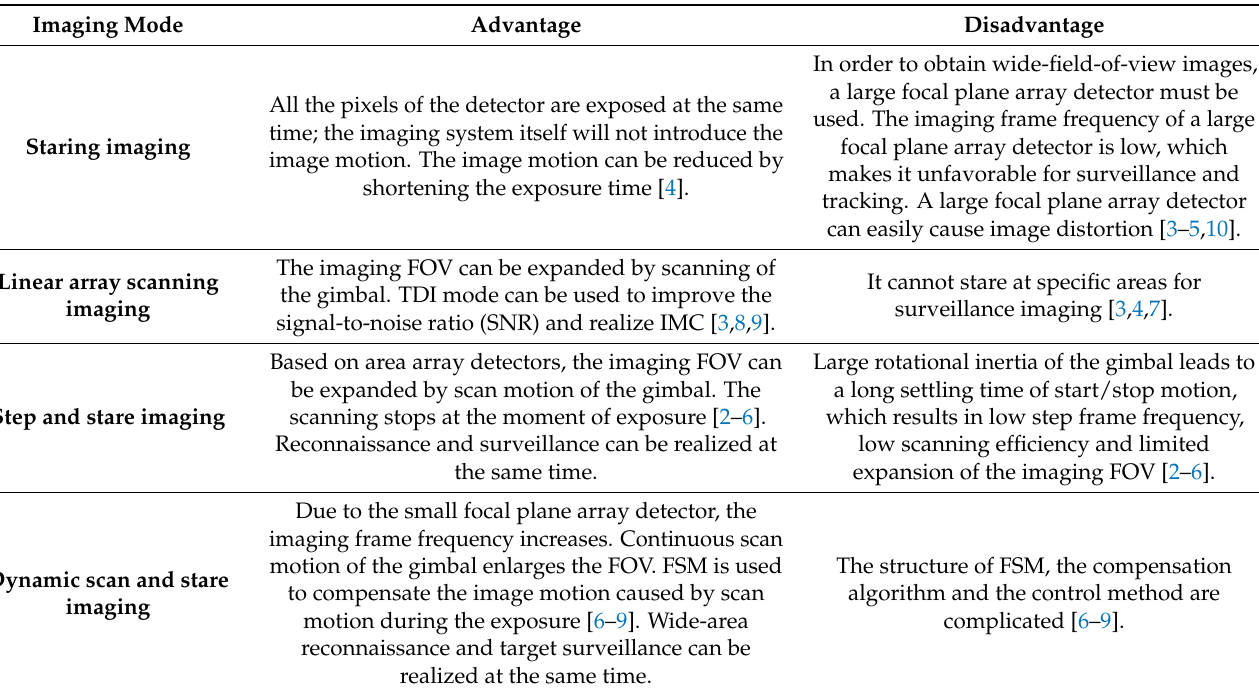
Table 1. Comparison of advantages and disadvantages of different imaging methods of aerial reconnaissance